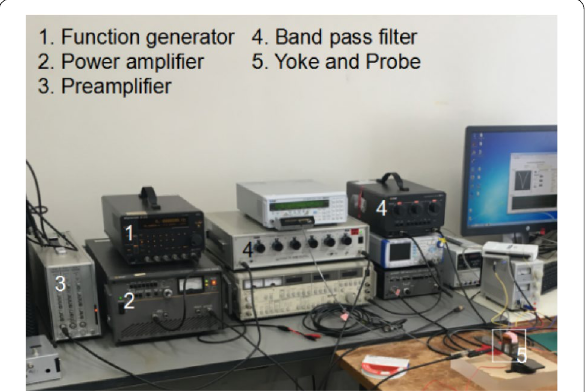
Figure 2 A photography of the MBN experimental